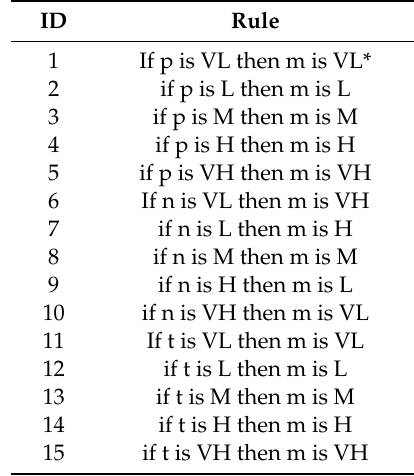
Table 3. Fuzzy rule base for the mass of grinding product.